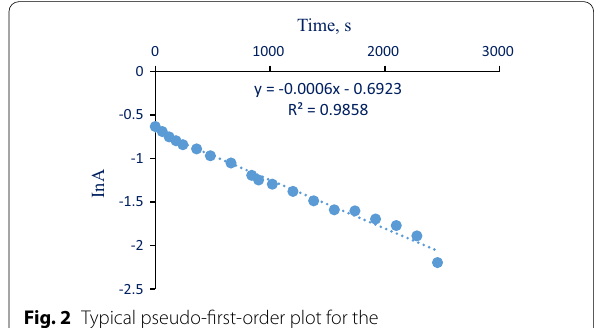
Fig. 2 Typical pseudo-first-order plot for the reaction of [Mo IV O 2 (paoH) 2 ] 2 − and ATH at [Mo IV O 2 (paoH) 22 − ] D 77.9, [ATH] =